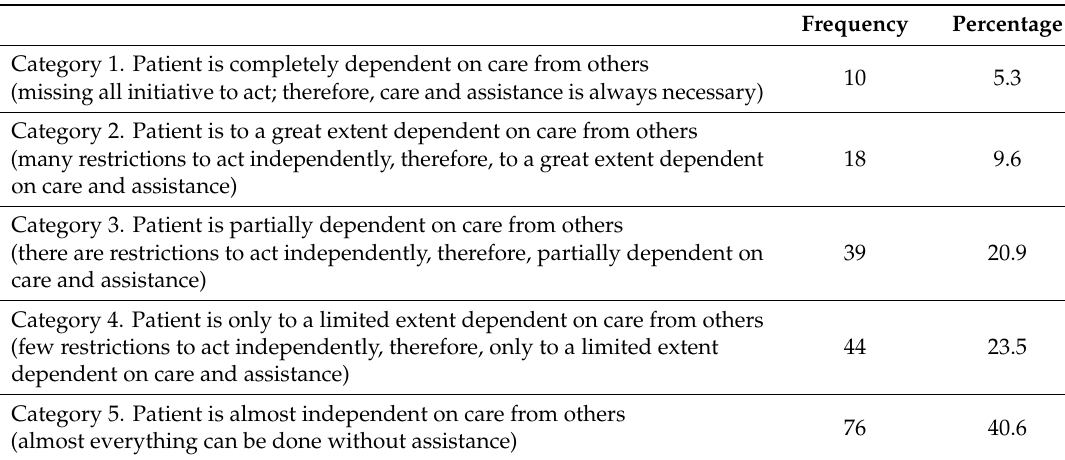
Table 3. Classification in the